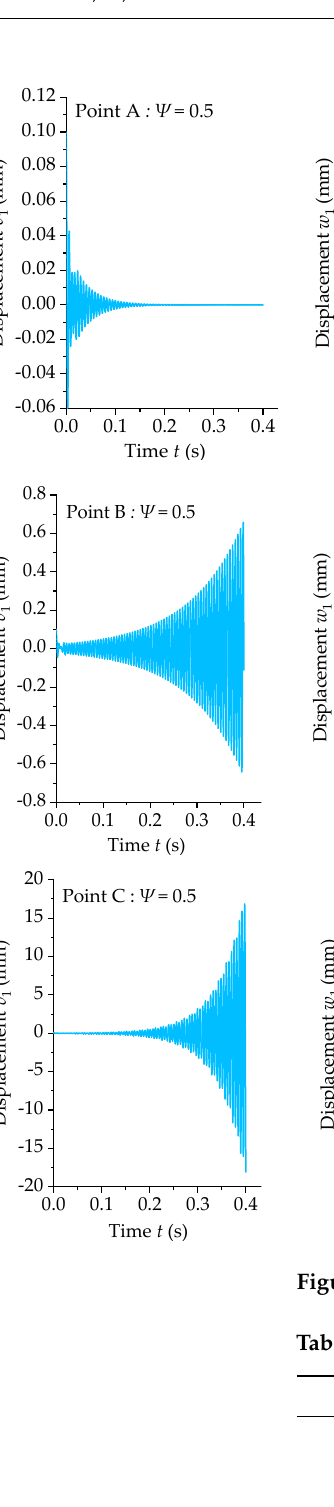
Table 4. Rotation speeds and cutting depths of the different points in Figure 11.